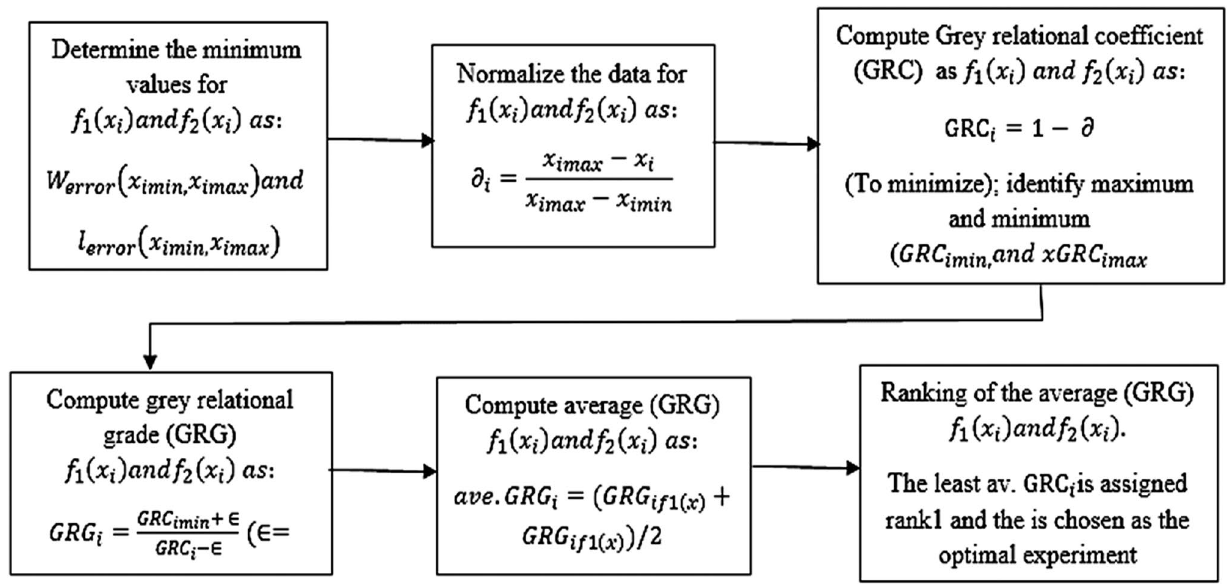
Fig. 3 Summary of the grey relational analysis